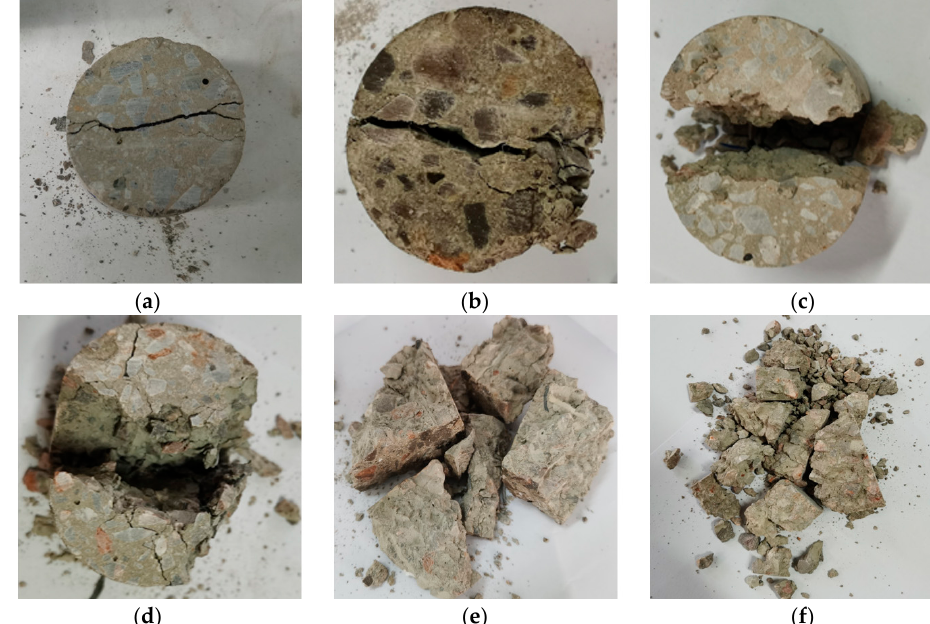
Figure 11. Failure modes of plain concrete at different temperatures: ( a ) 25 °C; ( b ) 100 °C; ( c ) 200 °C; ( d ) 400 °C; ( e ) 600 °C; ( f ) 800 °C.